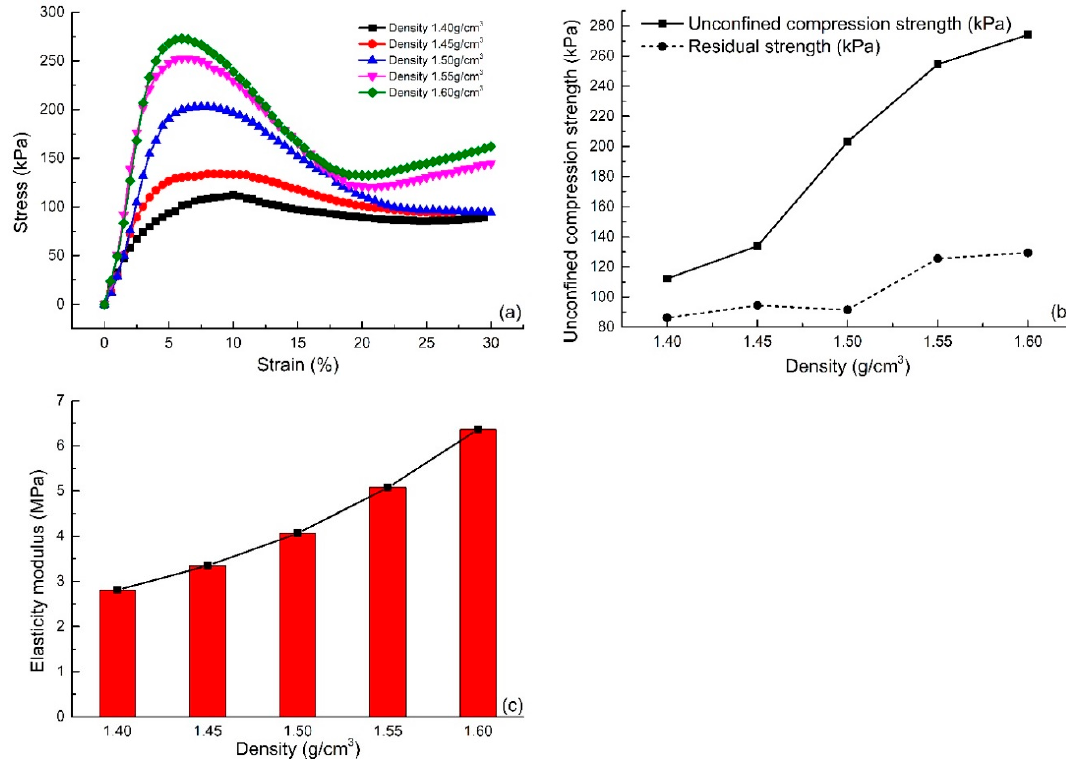
Figure 8. Effect of dry density on the unconfined compression test: ( a ) The stress-strain curves of different dry density; ( b ) The strength curves of different dry density; ( c ) The elasticity modulus curves of different dry density.